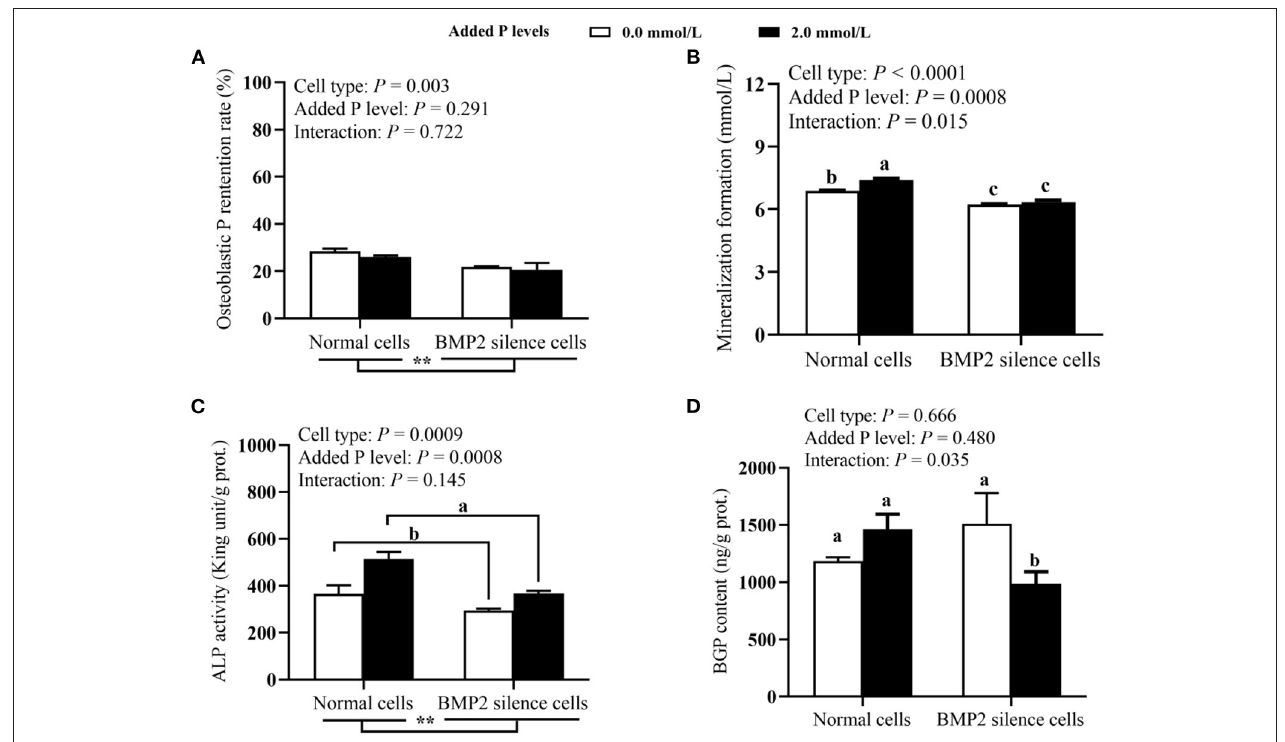
FIGURE 2 | Effects of cell types and P levels on the P retention rate (A) , mineralization formation (B) ALP activity (C) , and BGP content (D) in primary broiler osteoblasts (experiment 2). Each value represents the means ± SE, n = 4. Lacking the same letters (a, b, c) means significant differences, P < 0.05. ** P < 0.01. ALP,